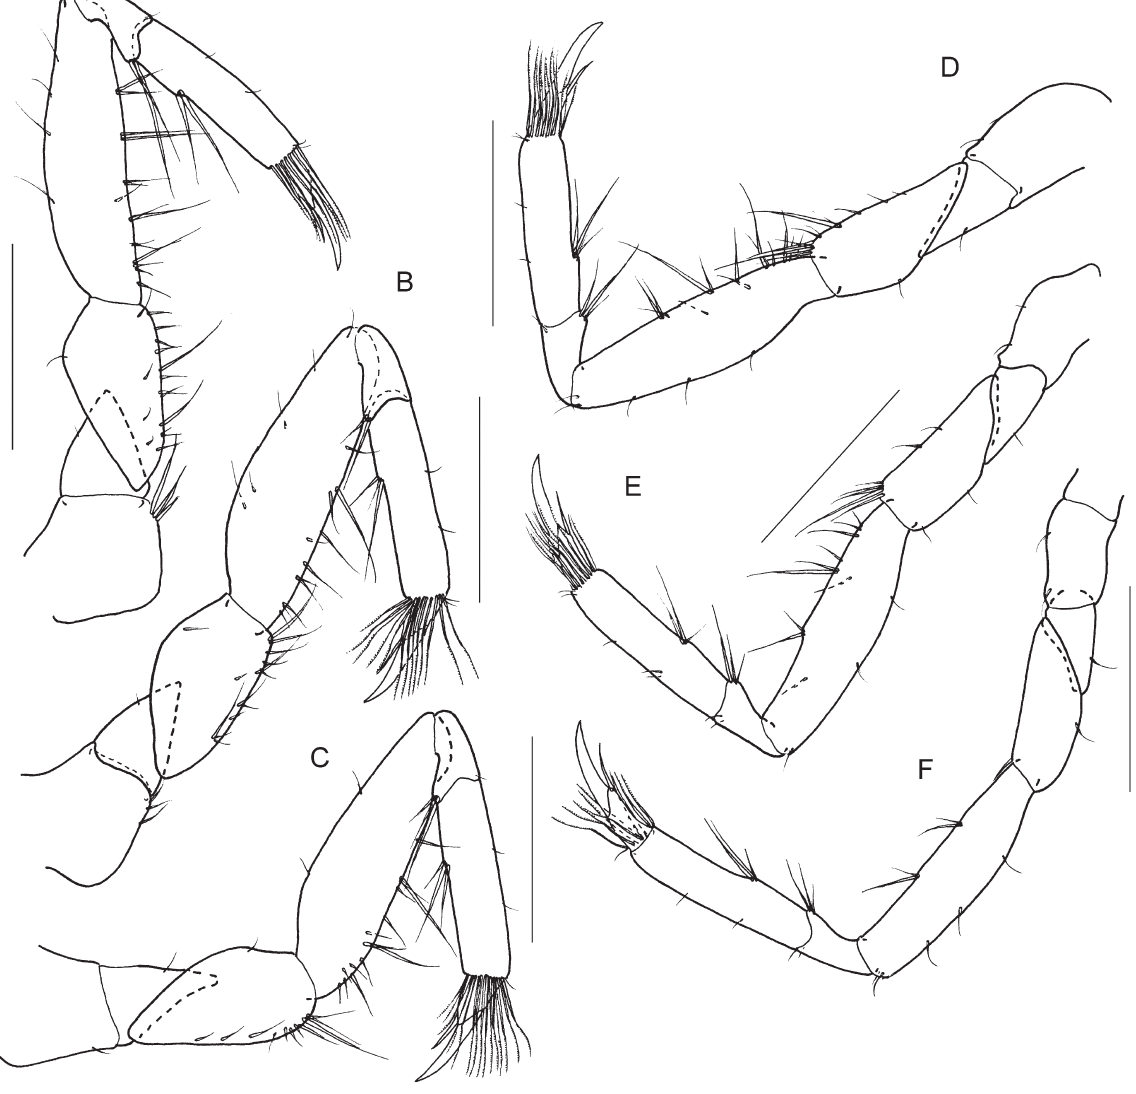
Fig. 25. Siriella tabaniocula sp. nov., holotype, ♀, length 6 mm, pereopod endopods, anterior views, Ningaloo Reef, Western Australia. A . Pereopod 1. B . Pereopod 2. C . Pereopod 3. D . Pereopod 4. E . Pereopod 5. F . Pereopod 6. Scale bars: 0.25